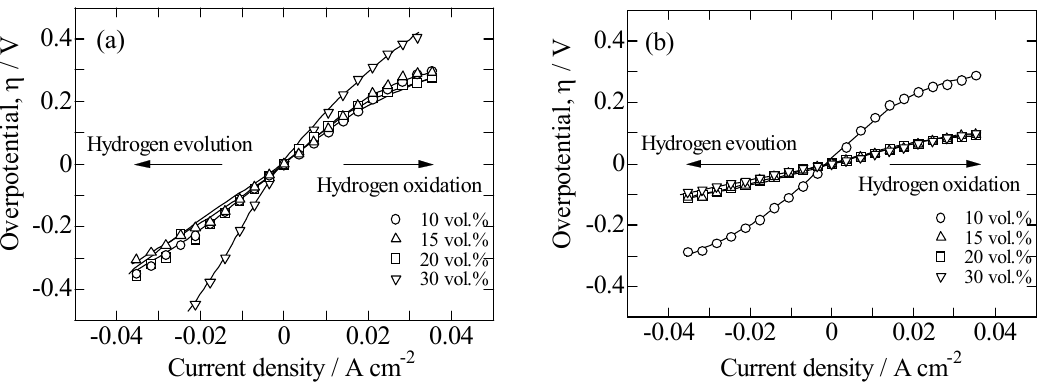
Figure 4. Polarization curves of Ni/BCZYN (x = 0), ( a ) and Ni/BCZYN (x = 0.03), ( b ) hydrogen electrode at various Ni loading amount.